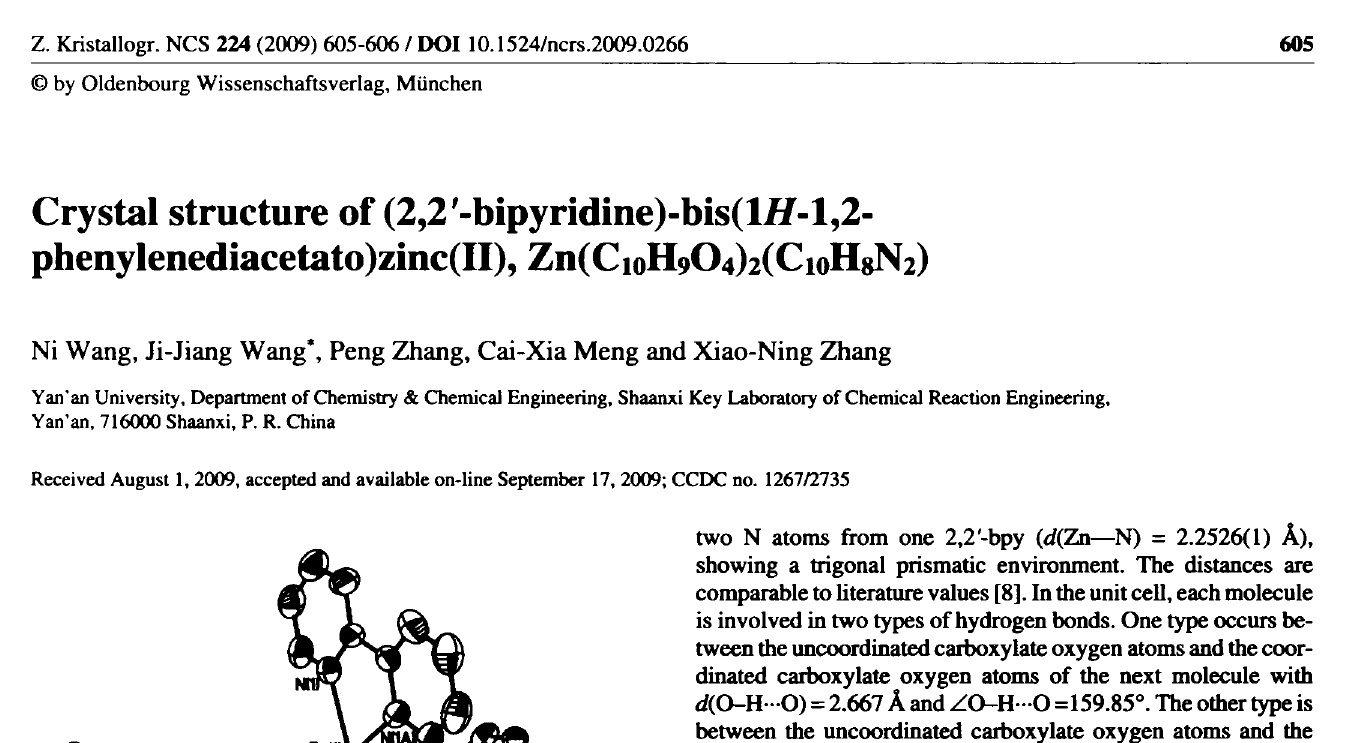
Table 1. Data collection and handling. Crystal: